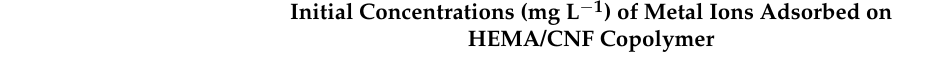
Figure 9. Pseudo second order models for the adsorption of 50 mg/L of ( A ) cadmium and ( B ) lead on electrospun HEMA/CNF copolymer using dose of adsorbent; 0.02 mg/mL, Temp; 25 °C.